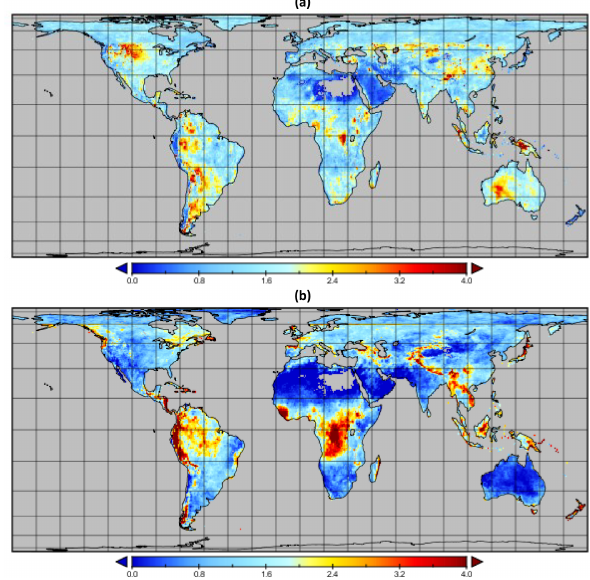
Figure 3. Uncertainty in the precipitation inputs to the eartH2Observe ensemble models: (a) uncertainty in precipitation extreme highs and (b) uncertainty in precipitation extreme lows (standard deviation (SD) taken across the precipitation products) in units of (occurrence of extreme events per year). Areas of con- sistently very low precipitation are masked in grey. Note that only isolated global areas exceeded four events per year, so the scale is restricted to zero to four events per